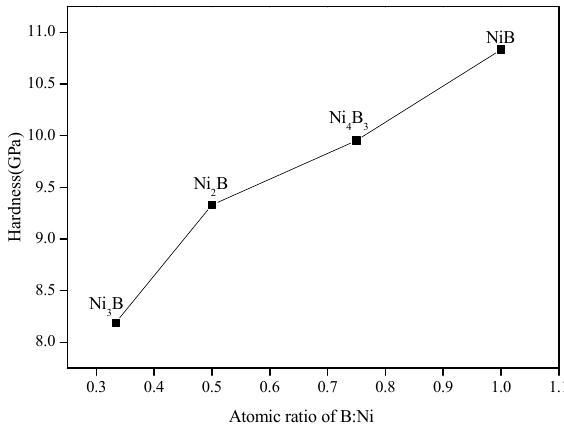
Figure 4. The hardness of Ni x B y compounds.